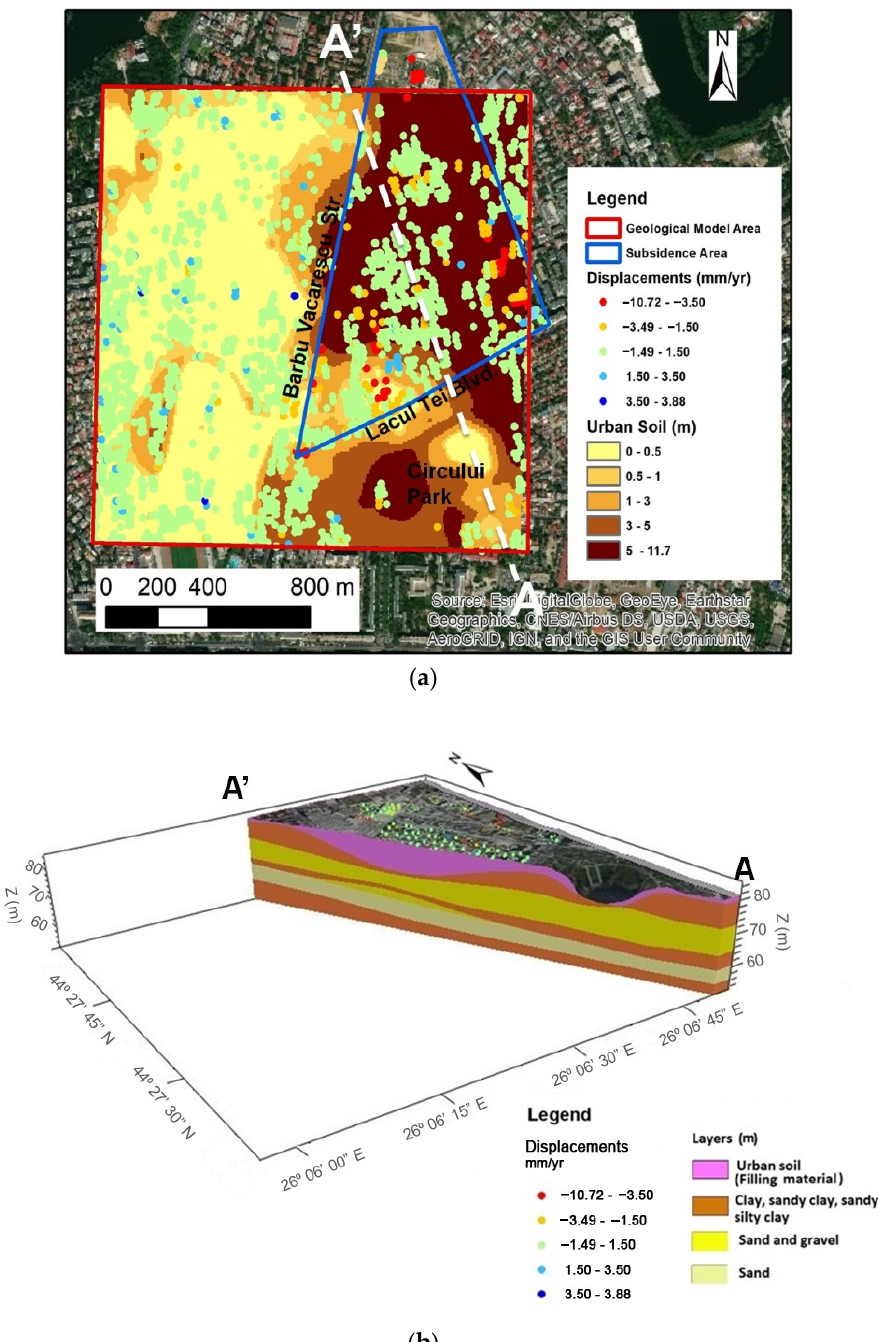
Figure 9. The Barbu Vacarescu area: ( a ) The thickness of the anthropogenic layer and the corresponding PS points. The geological cross-section is indicated along profile AA’ crossing the Barbu Vacarescu area and Circului Park from SE to NW. Map generated in Esri ® ArcMap™ 10.3. Base map source: ESRI World Imagery; ( b ) geological model following geological cross-section AA’ giving the lithological strata of the subsurface.